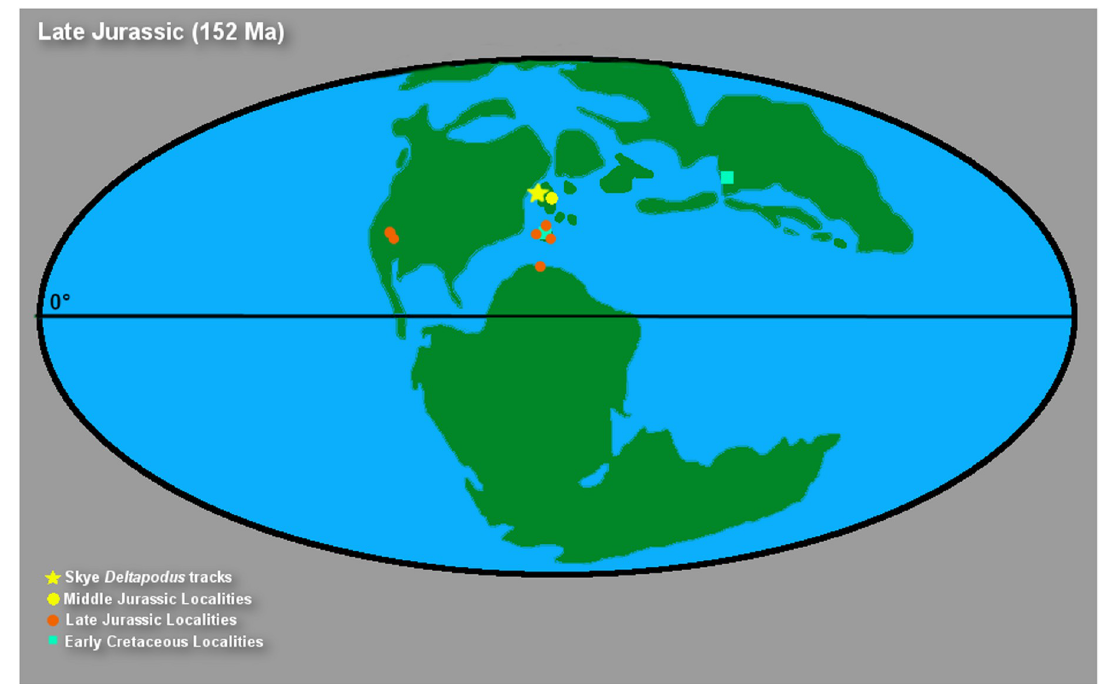
Fig 22. Global distribution of Deltapodus tracks. A paleogeographic reconstruction showing the global distribution of Deltapodus tracks (localities from [56, 81–84,86, 97, 98]). The majority of reported Deltapodus tracks are concentrated in western Europe, primarily in Iberia and the UK, while sparser groupings exist in the western United States, China, and northern Africa. The yellow, orange, and teal symbols indicate Middle Jurassic-aged, Late Jurassic-aged, and Early Cretaceous-aged localities respectively. The Skye Deltapodus tracks represent the most northerly occurrence of the ichnogenus. Paleomap redrafted from